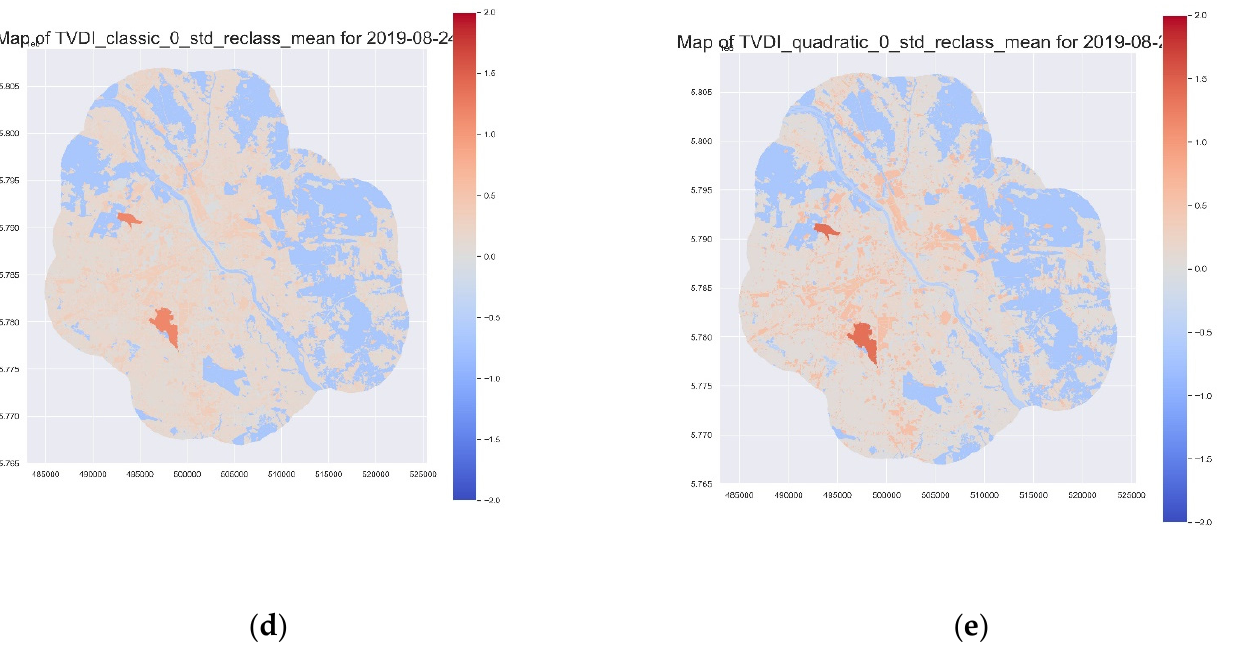
Figure 6. Distribution maps of means of standardized, calculated, and reclassified indices on 24 August 2019, ( a ) LST , ( b ) NDVI , ( c ) NDBI , ( d ) TVDI , ( e ) qTVDI . [Coordinates are in meters]